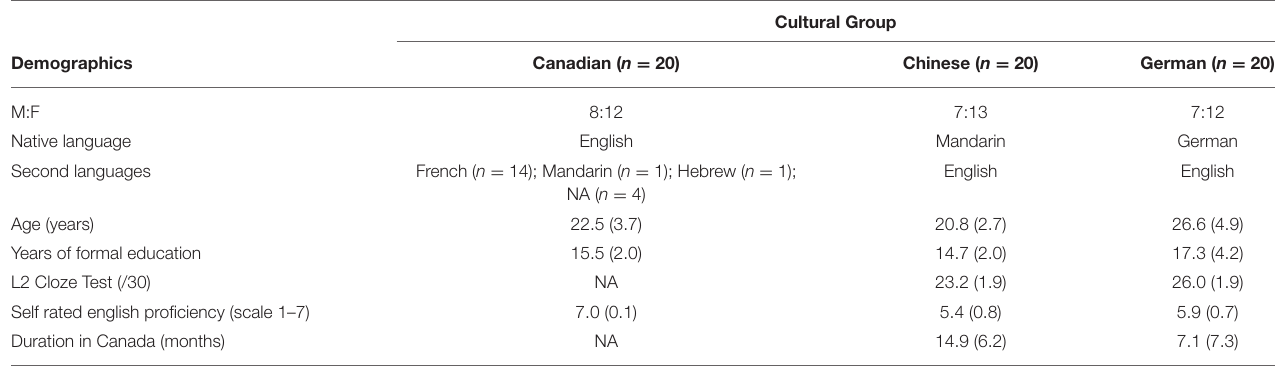
TABLE 1 | Demographic information for all three cultural groups (Canadian, Chinese, German, N =